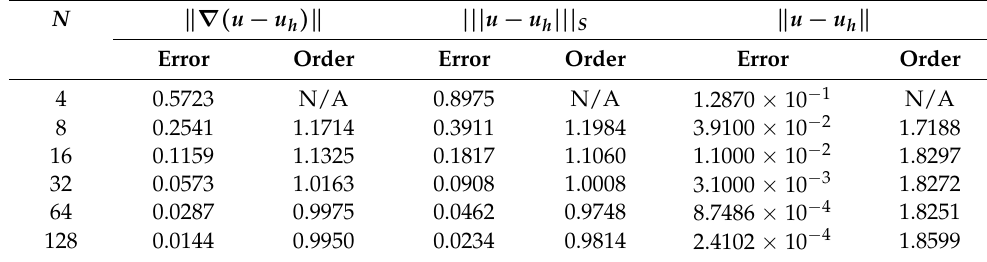
Figure 8. B.C. V. Table 4. Experiment results for the exact solution u = x 2 e y with B.C. I.